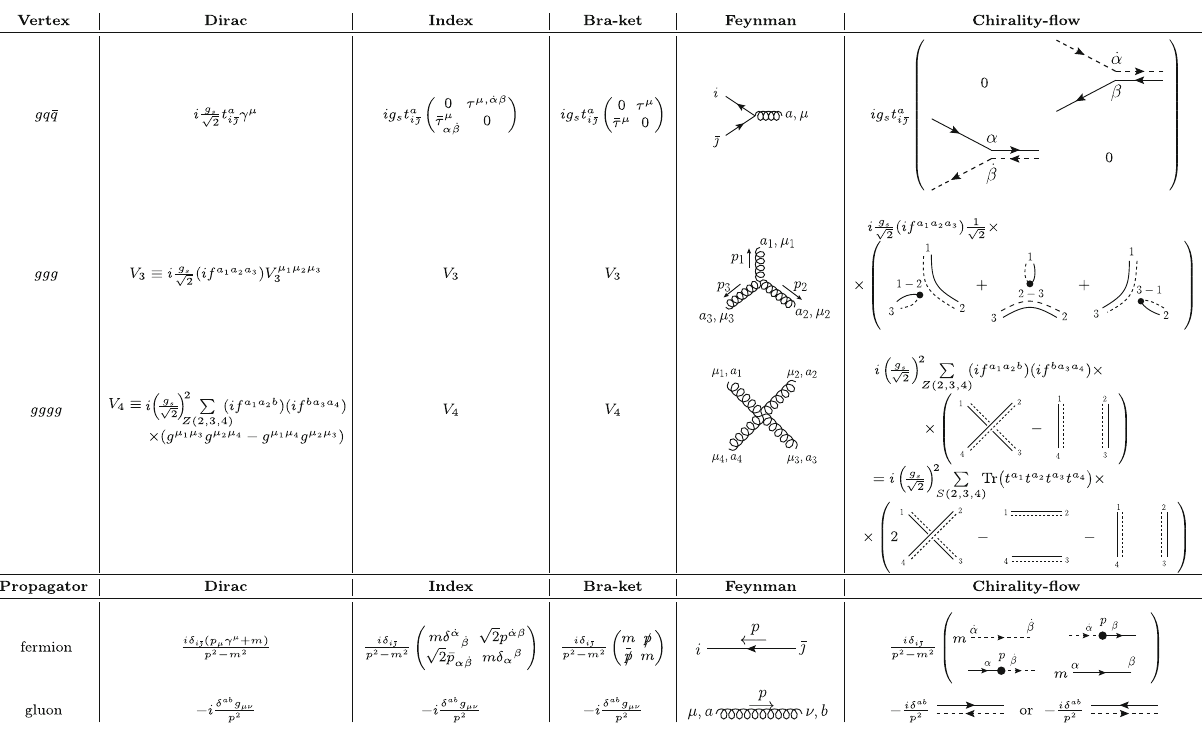
Table 2 The QCD “Rosetta Stone” translating the chirality-flow nota- tion to widely-used spinor-helicity notations. Here Z ( 2 , 3 , 4 ) denotes the set of cyclic permutations and S ( 2 , 3 , 4 ) the set of all permutations μ 1 μ 2 μ 3 of the integers 2 , 3 , 4, and V 3